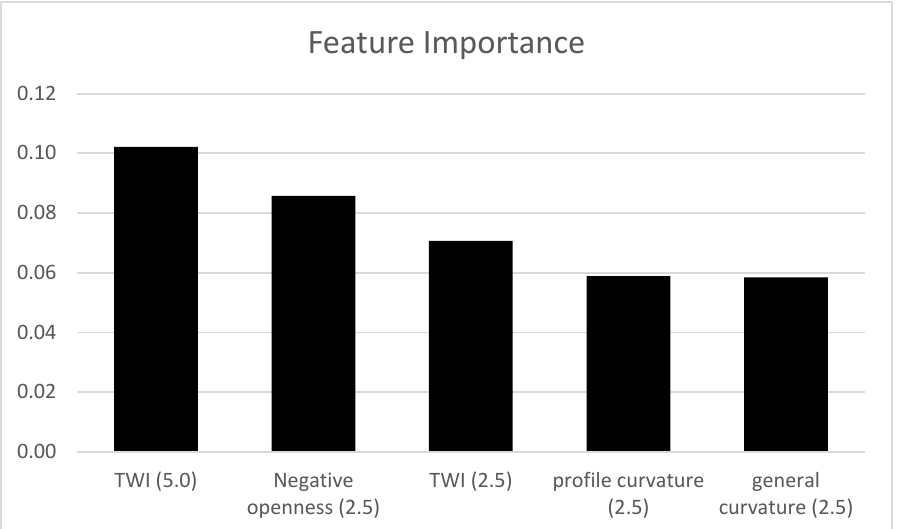
Figure 6. Permutation importance in random forest classification for top-performing set of terrain attributes. The numbers in parentheses indicate the degree of DEM smoothing (sigma in meters) prior to terrain-derivative algorithm application. TWI values are calculated with the multiple-flow-direction algorithm and convergence factor equal to 1.1 [22]. Negative openness is from [24]. Curvature calculations are from [16].